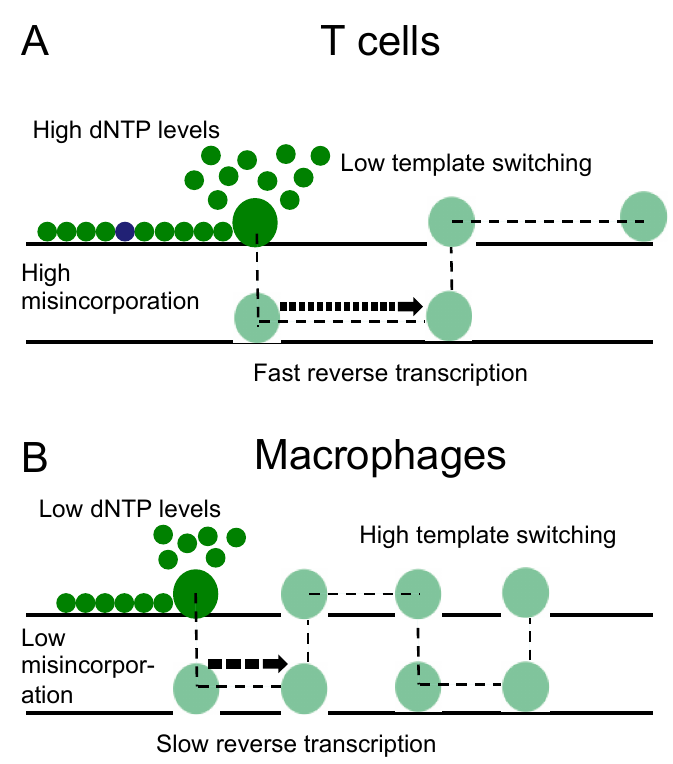
Figure 5. Reverse transcription associated with different dNTP concentrations in T lymphocytes and macrophages. ( A ) T-cells have high dNTP concentrations and associated with this higher mutation rates but lower rates of strand transfer; ( B ) monocyte-derived macrophages (MDMs) have lower dNTP concentrations and associated higher rates of strand transfer, but lower mutation rates.